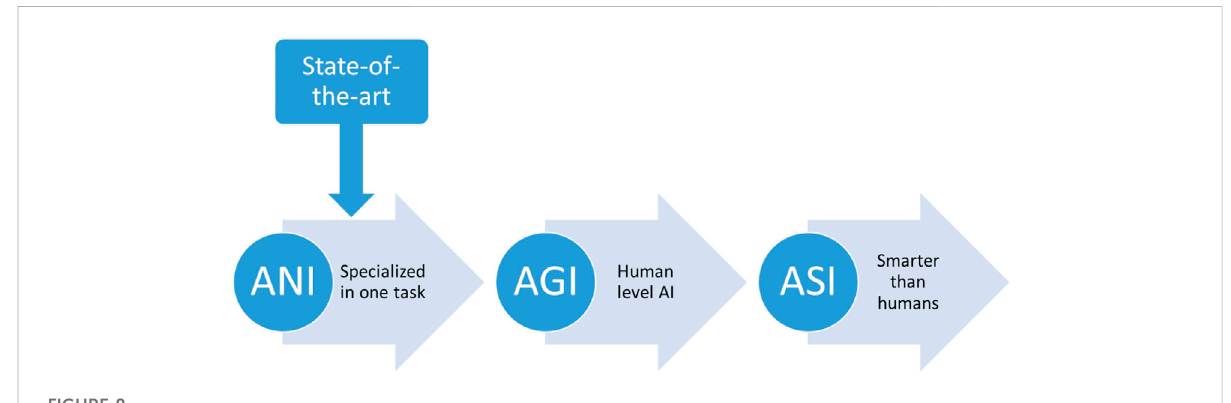
FIGURE 8 Various stages of AI